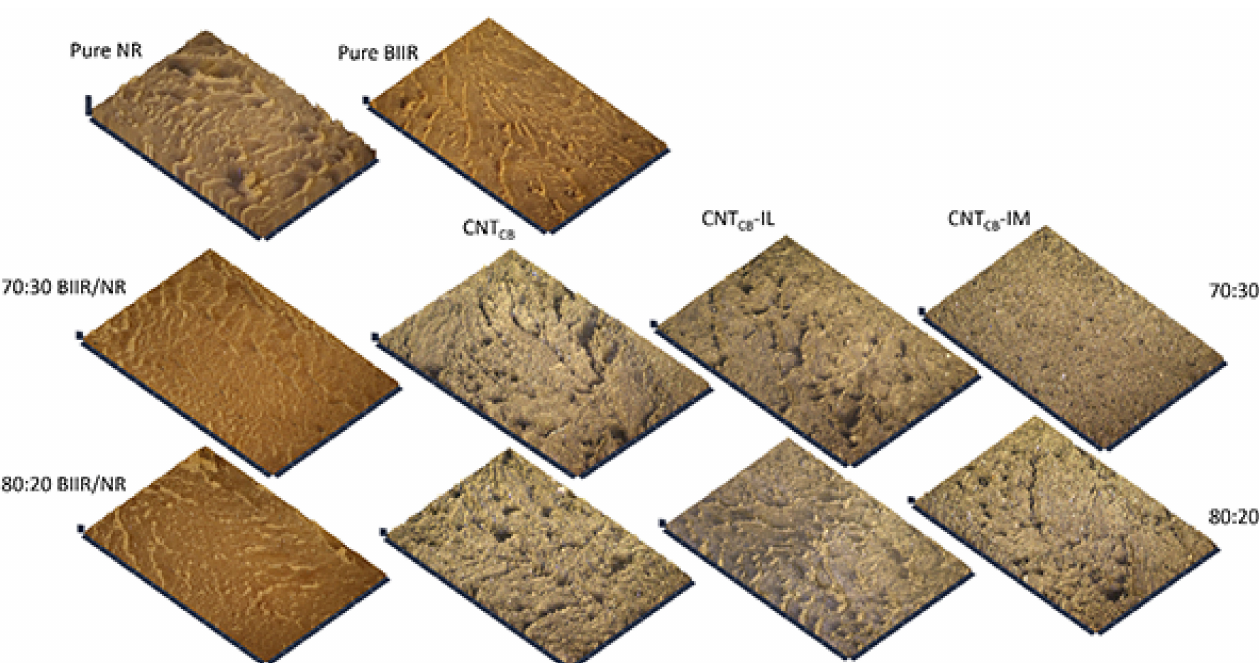
Figure 15. Surface roughness of pure rubbers and their composites with and without IL and IM modifiers, BIIR:NR ratios of 70:30 and 80:20 after Taber abrasion testing.